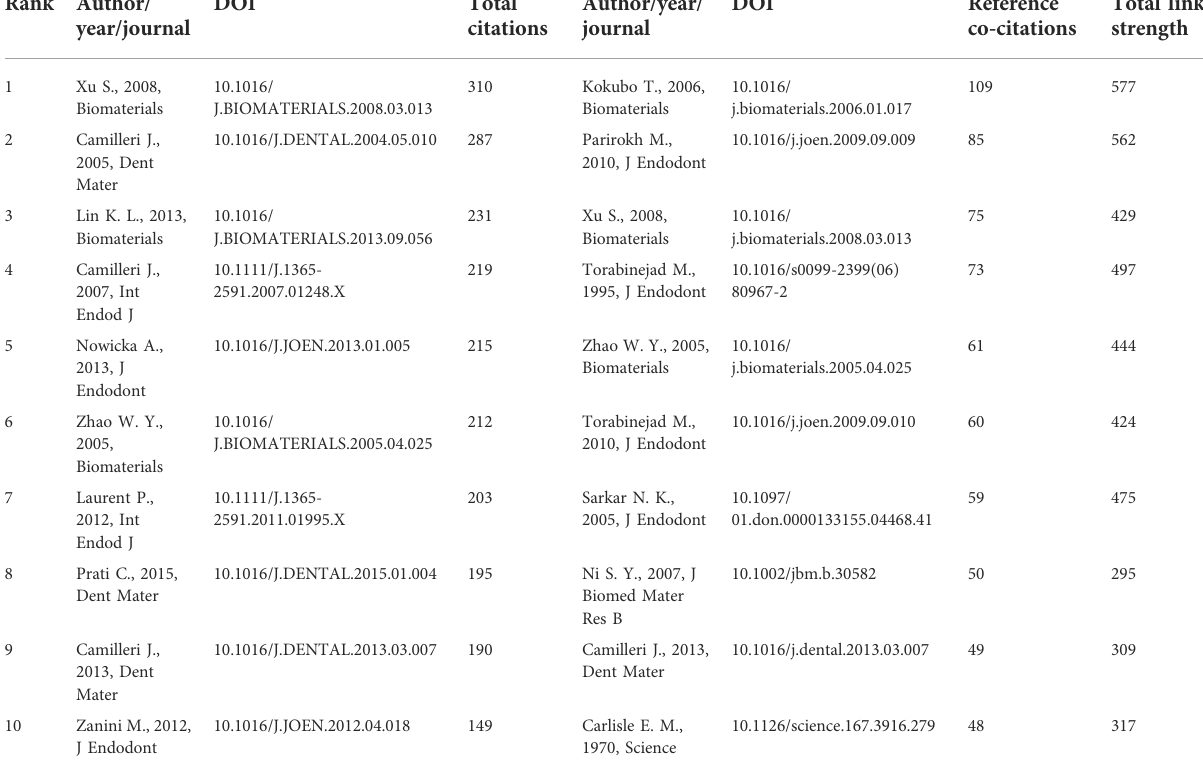
TABLE 3 TOP 10 article by cited and co-cited reference of CSB in medicine fi